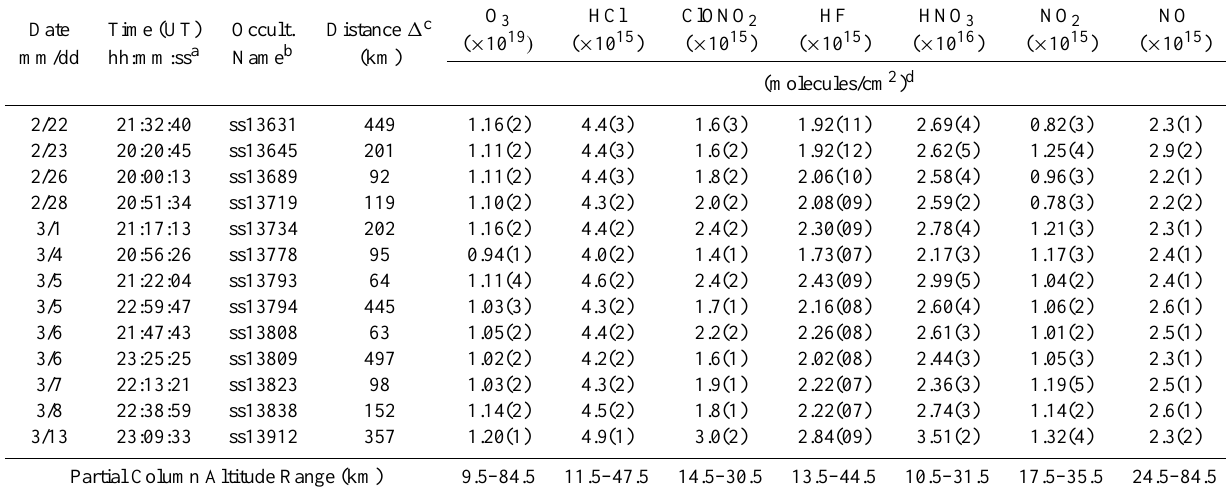
Table 4. Partial columns calculated from ACE-FTS measurements taken during the 2006 Canadian Arctic ACE Validation